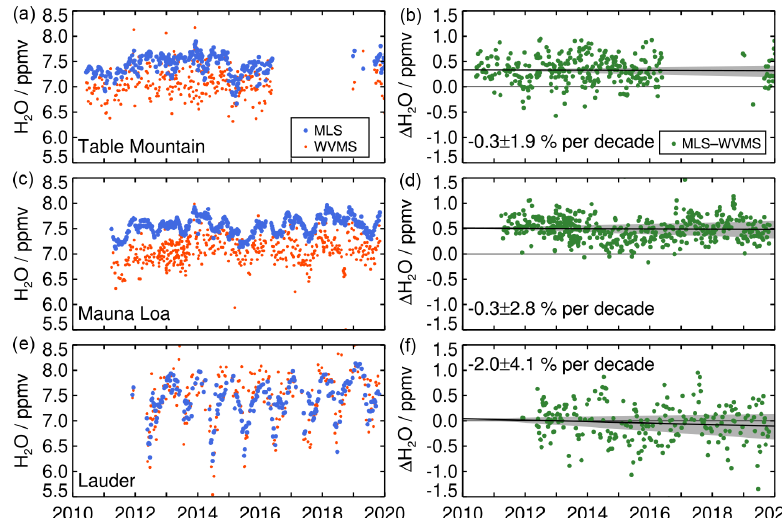
Figure 4. Panels (a) , (c) , and (e) show WVMS observations of 55km lower-mesospheric water vapor in red and coincident (within ± 2 ◦ latitude and ± 30 ◦ longitude) MLS observations in blue. The WVMS data are from roughly week-long integrations, and the MLS points are averages of all spatially coincident observations in a 1-week window centered on the middle of each WVMS observation period. Pan- els (b) , (d) , and (f) show the corresponding differences (MLS minus WVMS) and an associated linear fit (with shading indicating the 1-year block bootstrap 95% confidence range for the slope). Drift rates (converted from ppmv to percent) and an associated 2 σ uncertainty are quoted in each panel.